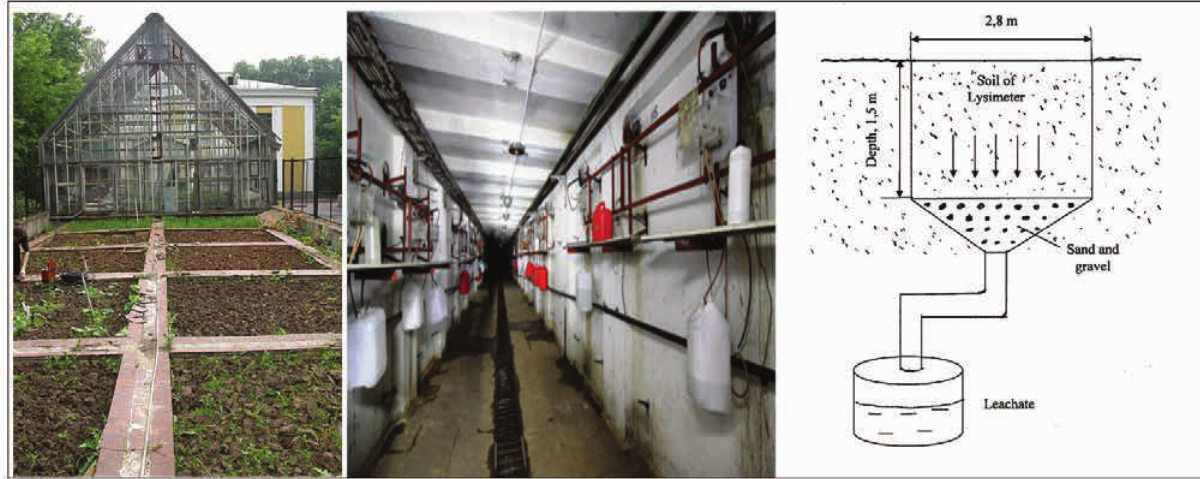
Figure 2: Lysimeters of MSU